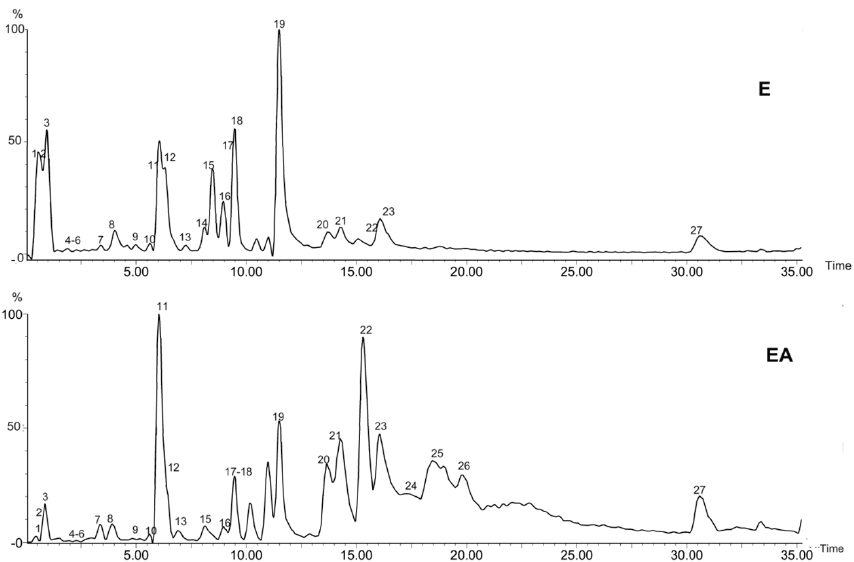
Figure 1. Base peak chromatogram (BPC) of the ethanol fraction (E) and the ethyl acetate fraction (EA) of P. delavayi root (negative mode).